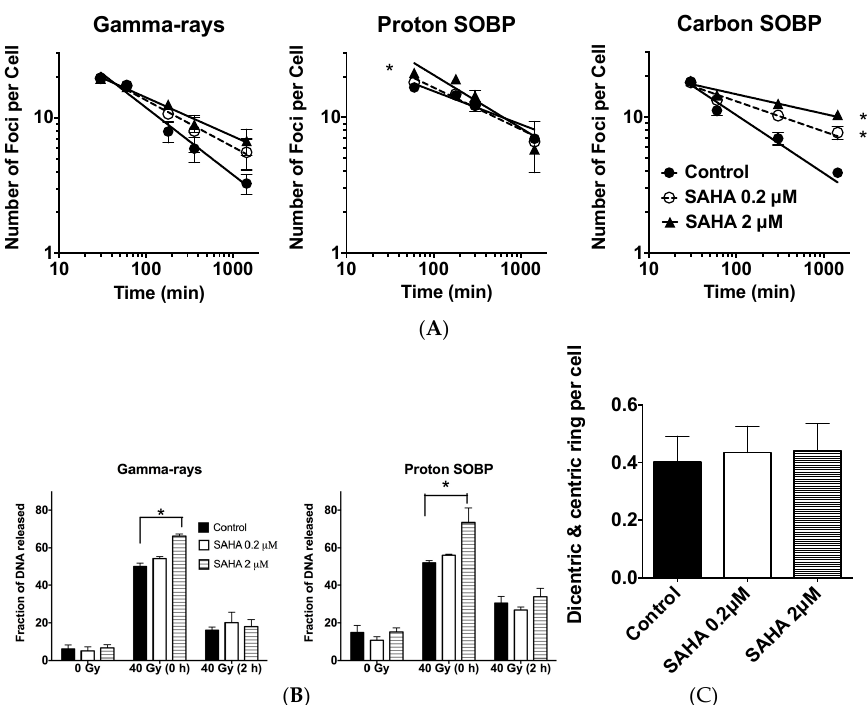
Figure 4. SAHA induced radiosensitization in DNA damage and repair. ( A ) γ -H2AX foci kinetics in AG1522 cell lines after 1 Gy of different radiation qualities; ( B ) Constant field gel electrophoresis analysis in A549 after 40 Gy of radiation; ( C ) Chromosome aberrations after 4 Gy of γ -ray irradiation to AG1522. Error bars indicate standard error of the means. All experiments were carried out at least three times independently. * marks indicate statistically significant differences ( p < 0.05).